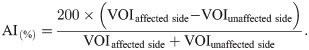
The AI of the 35 VOI pairs from the 7 patients were plotted in each graph, where the AI of each VOI value was expressed as:
AI(%)=200×(VOIaffectedside−VOIunaffectedside)VOIaffectedside+VOIunaffectedside.
Here, in this study, the “affected side” was left in the case 1, 2, 4–7, and right in the case 3 (Table 1), and the “unaffected side” was contralateral to the “affected side”.Significant correlations were found between (A) the AI of IMZ-EF and the AI of OEF, (B) the AI of approx IMZ-EF and the AI of OEF, (C) the AI of IMZ-K1 and AI of CMRO2, (D) the AI of early-SPECT and the AI of CMRO2, (E) the AI of IMZ-K1 and the AI of CBF, (F) the AI of early-SPECT and the AI of CBF, (G) the AI of IMZ-PS and the AI of O2-PS, (H) the AI of IMZ-K1 and the CMRO2, and (I) the AI of IMZ-EF and the OEF.